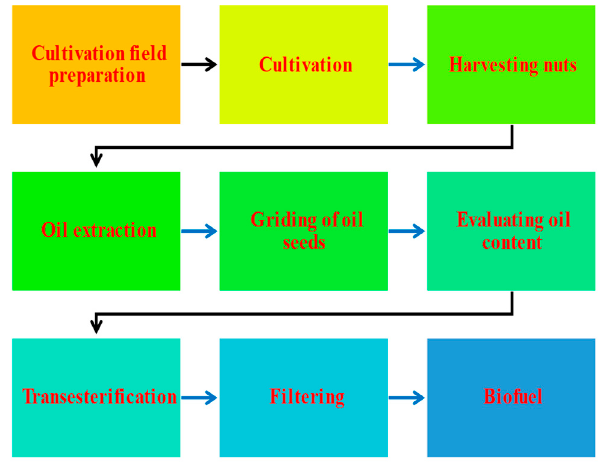
Figure 3. Schematic of a simplified Jatropha bio refinery showing the stages, processes, and opera- tional requirements of biodiesel production methods.